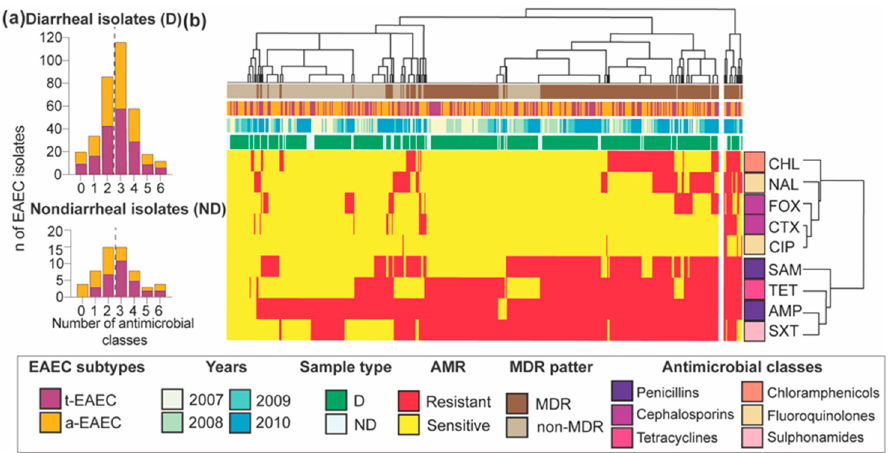
Figure 3. Prevalence of AMR phenotypes from t-EAEC and a-EAEC isolated from diarrheal and non-diarrheal cases. ( a ) Histograms illustrating the number of drug classes to which t-EAEC and a-EAEC isolates were phenotypically resistant. ( b ) The percentage of AMR phenotypes stratified by year. D = diarrheal; ND = non-diarrheal; AMP, ampicillin; SAM, ampicillin-sulbactam; SXT, trimethoprim-sulfamethoxazole; CHL, chloramphenicol; FOX, cefoxitin; CIP, ciprofloxacin; NAL, nalidixic acid; TET, tetracycline; CTX, cefotaxime; MDR, multidrug-resistant.